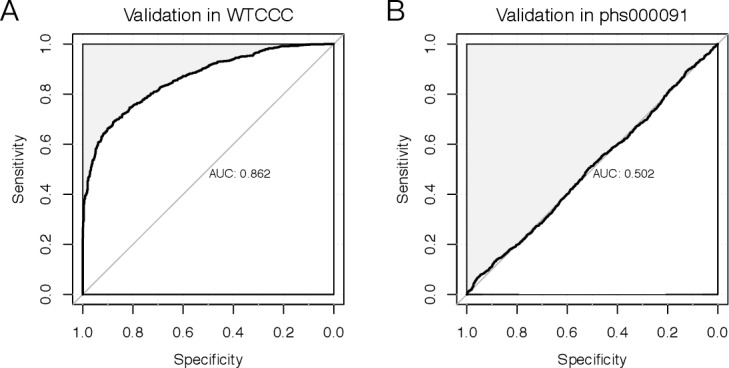
The receiver operating curve for the risk prediction model.(A) WTCCC refers to British population; (B) phs000091 refers the EA samples.